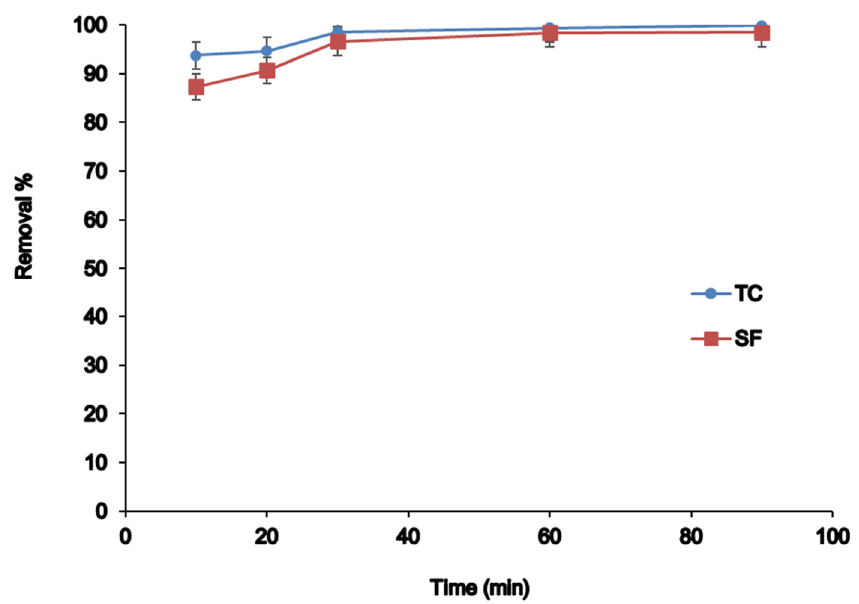
Figure 7. The effect of contact time on removal efficiency.